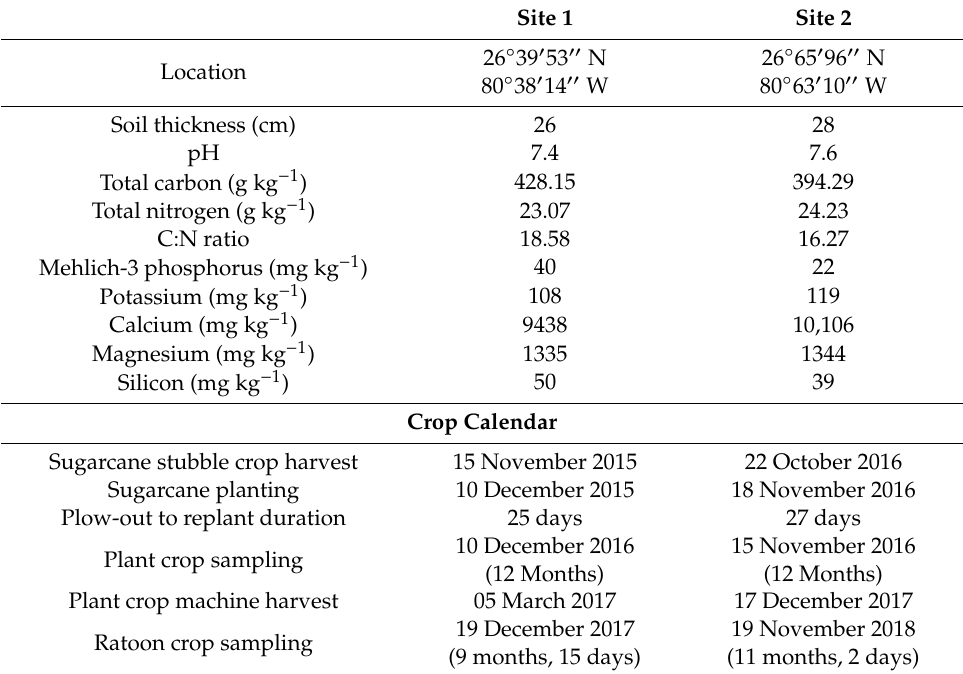
Table 1. Physicochemical soil properties of experimental sites prior to sugarcane planting and calendar of events for plant cane and first ratoon